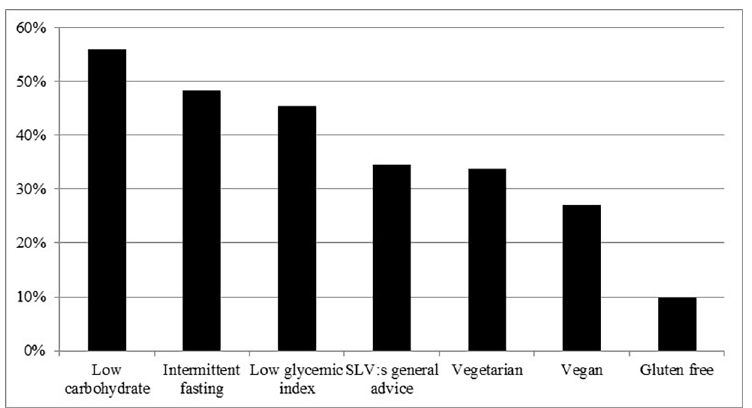
Fig 2. The proportion of the SWEDIET-2017 participants who believes diets are very or partly efficient for weight loss. SLV; Swedish National Food Agency.